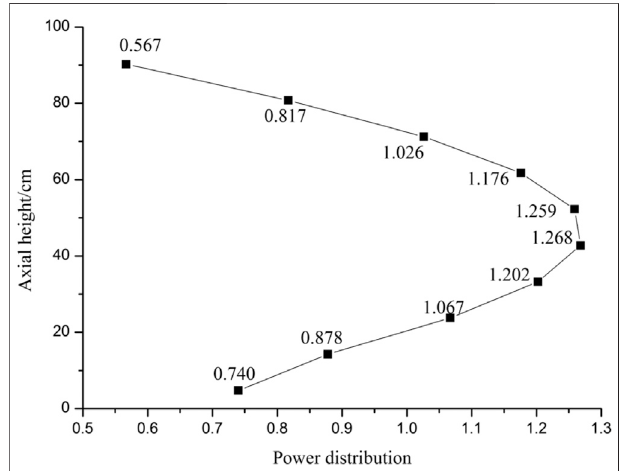
FIGURE 6 | Axial power distribution result of the